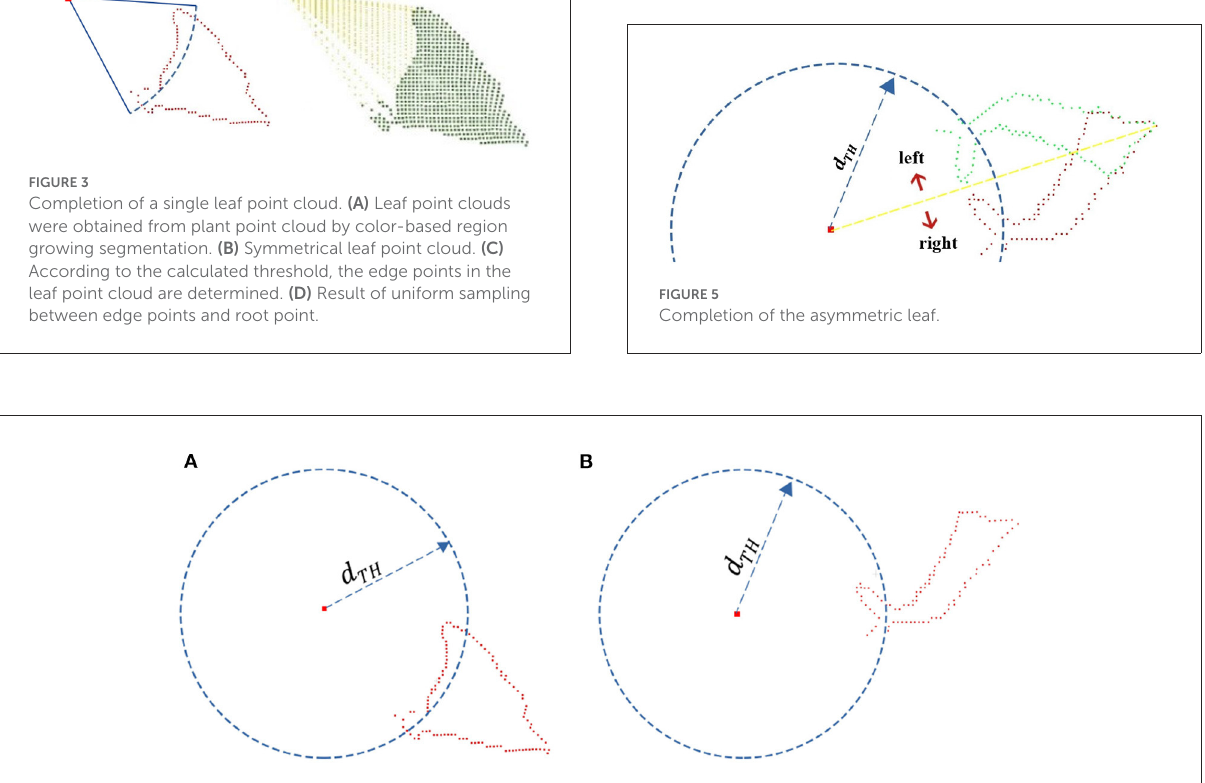
FIGURE4 The determinate closest edge. (A) Symmetrical leaf. (B) Asymmetrical